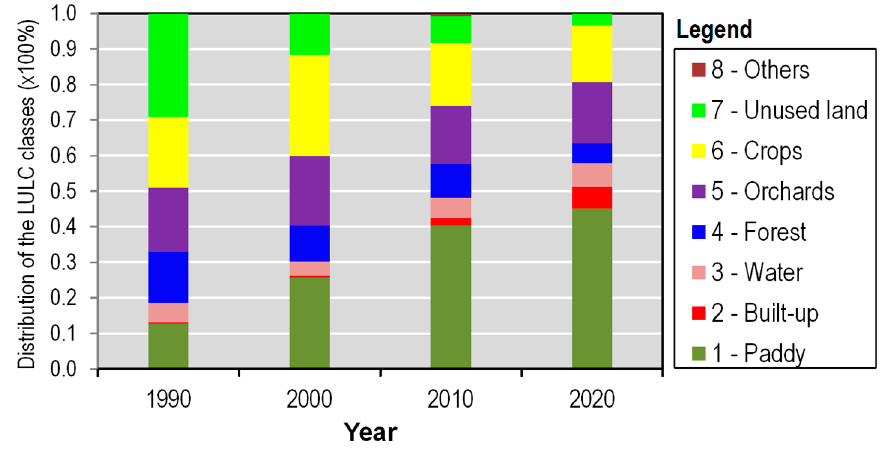
Table 6. The magnitudes and annual rate changes for the LULC classes in the Dong Thap Muoi area for the period 1990–